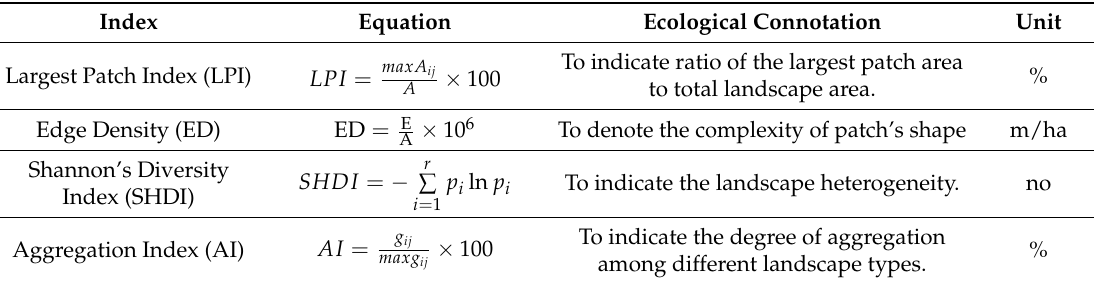
Table 4. Descriptions of the landscape metrics used in